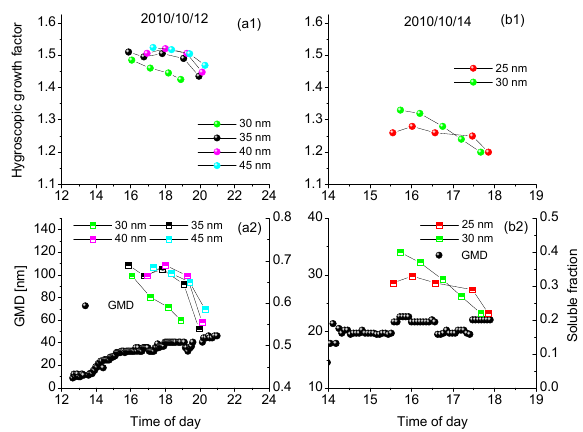
Fig. 4. The temporal evolution of GMD, HGF, and the soluble Fig. 4: The temporal evolution of GMD, HGF, and the soluble equivalent fraction ( ε H2SO4- 720 equivalent fraction ( ε H equivalent ) during the two NPF events. Time is indicated in local time. 721 Time is indicated in local